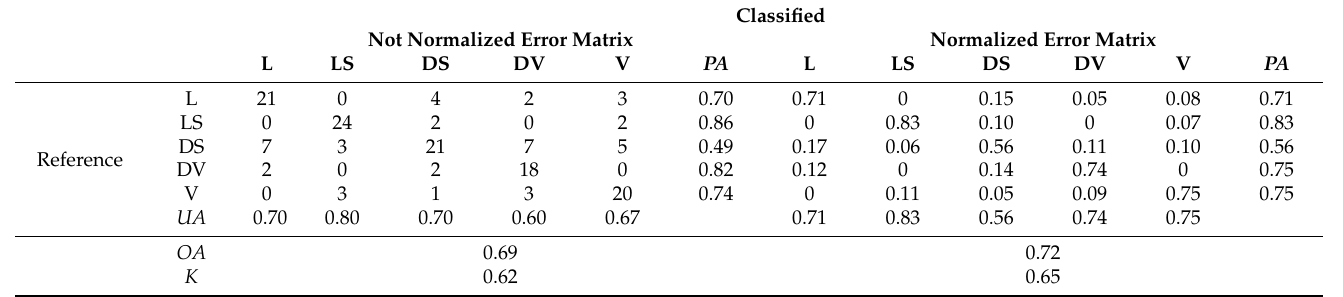
Table 6. Accuracy assessment of the image of the arid period over the whole basin. Classified Not Normalized Error